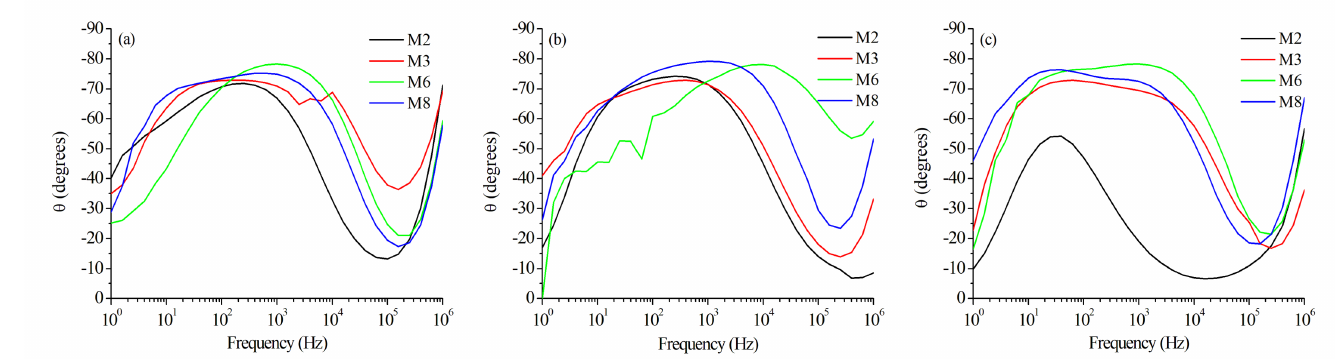
Figure 14. Phase in Bode plots for selected samples in different zones: ( a ) Base Metal, ( b ) Weld Zone, and ( c ) Heat-Affected